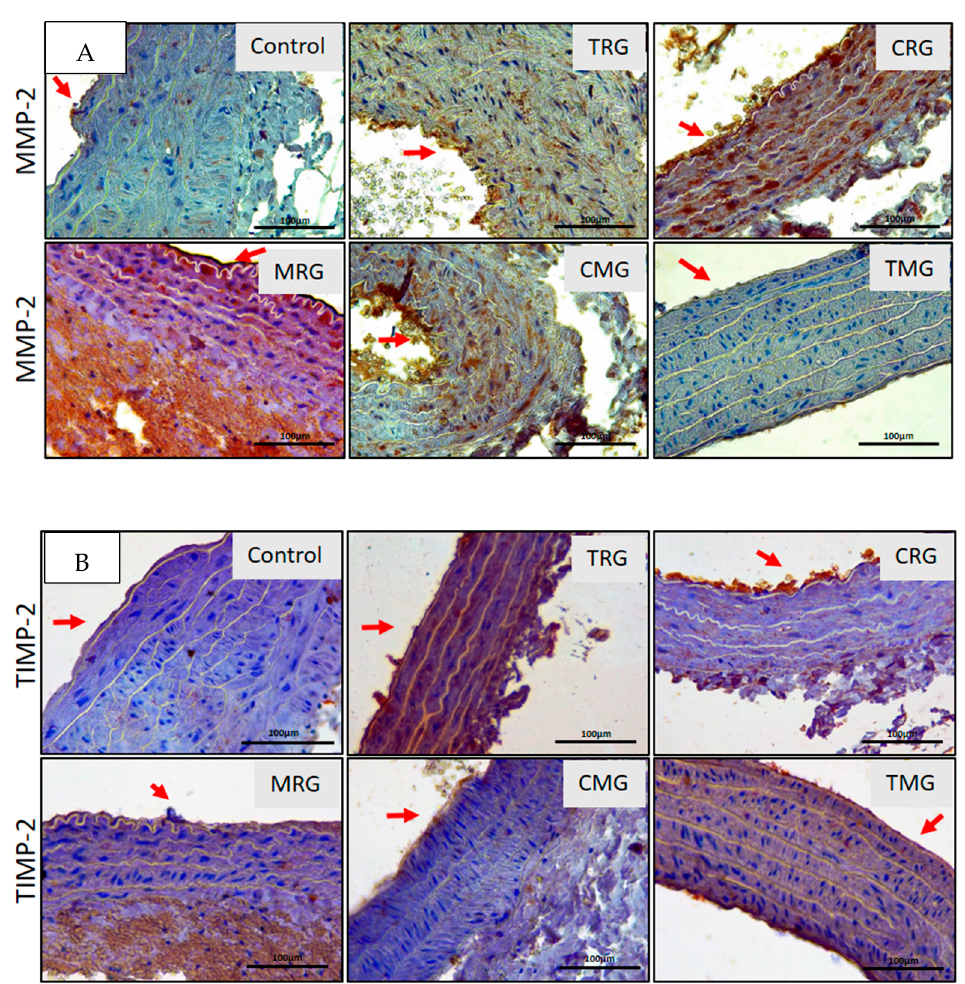
Figure 5. Immunolocalization of MMP-2 ( A ) and TIMP2 ( B ) in aorta of rats in all groups. Red arrows indicate aortal intima. IHC A and B. Objective magn. ×40; bar 100 μ m.